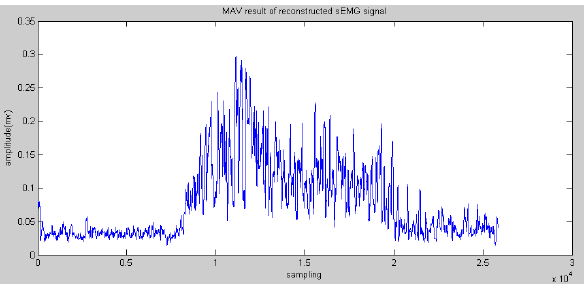
Figure 7. Mean Absolute Value (MAV) results of reconstructed sEMG signals in node 4.0.